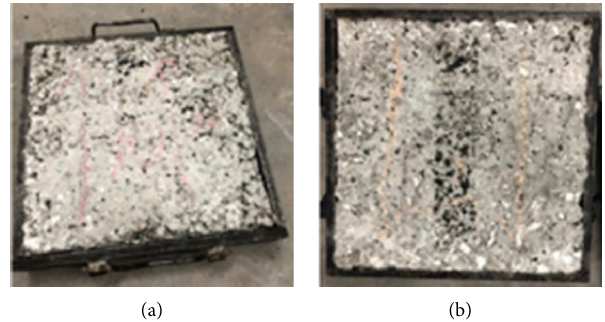
Figure 16: Damaged forms of the specimen after the high-temperature test. (a) Rutting plates. (b) Rutting plate after the test. Table 19: Data processing results of high-temperature stability tests at diferent cement slurry strengths. D Cement slurry 1 strength (MPa)